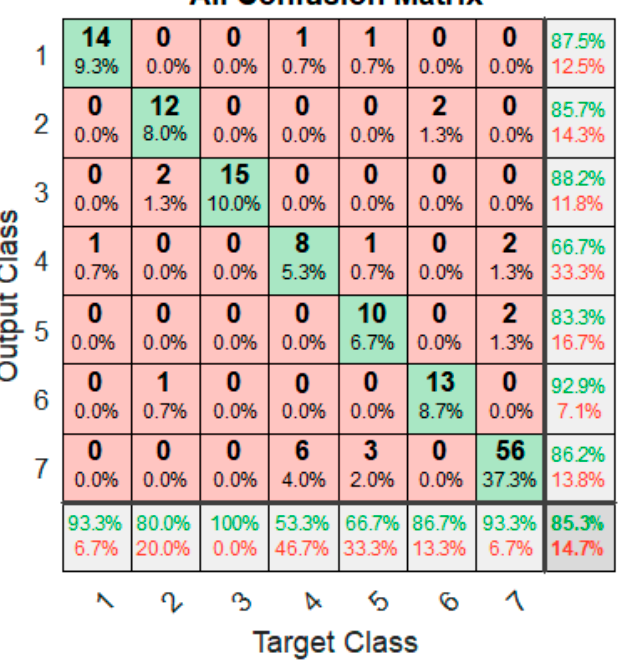
Figure 7. Confusion matrix of classification results.